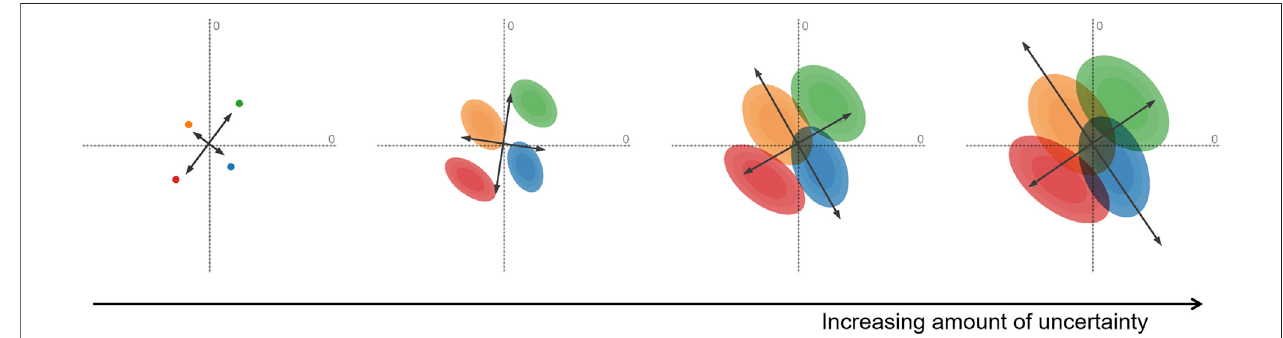
FIGURE 2 | Uncertainty-aware PCA applied to a simple test data set with four points with two data dimensions. Increasing the amount of uncertainty attached to the data points, we obtain wider and wider distributions (here, normal distributions) that lead to larger and larger coverage in the visualization. However, the changes in the distributions of uncertain input even affect the computation of the PCA axes: they are rotated to re fl ect the changing distribution of the input. Image: © 2020 IEEE. Reprinted, with permission, from Görtler et al.